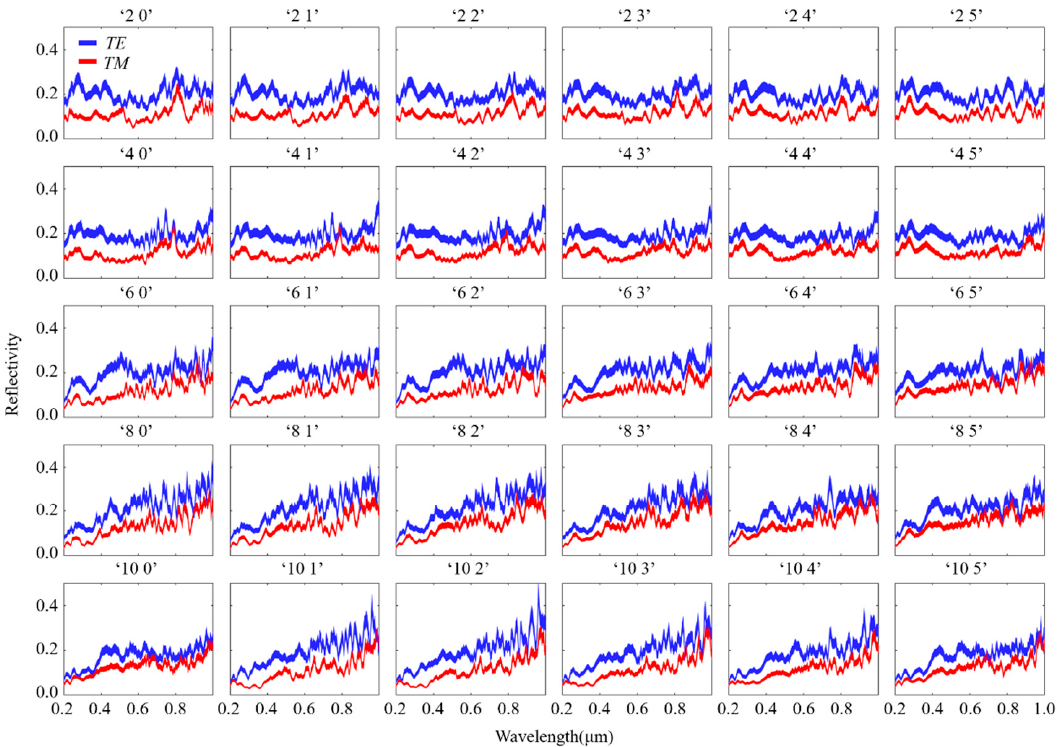
Figure 6. Simulated wavelength-dependent spectra for 30 of the 120 data sequences (slope angle combined with azimuth).